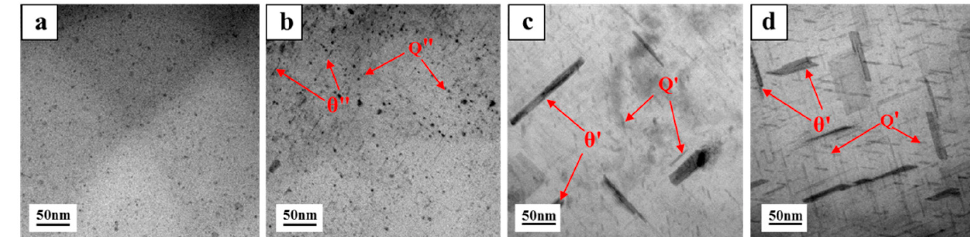
Figure 4. Precipitate in the Cd-free alloy after aging treatment: ( a ) 2 h; ( b ) 12 h; ( c ) 24 h; ( d ) 48 h.